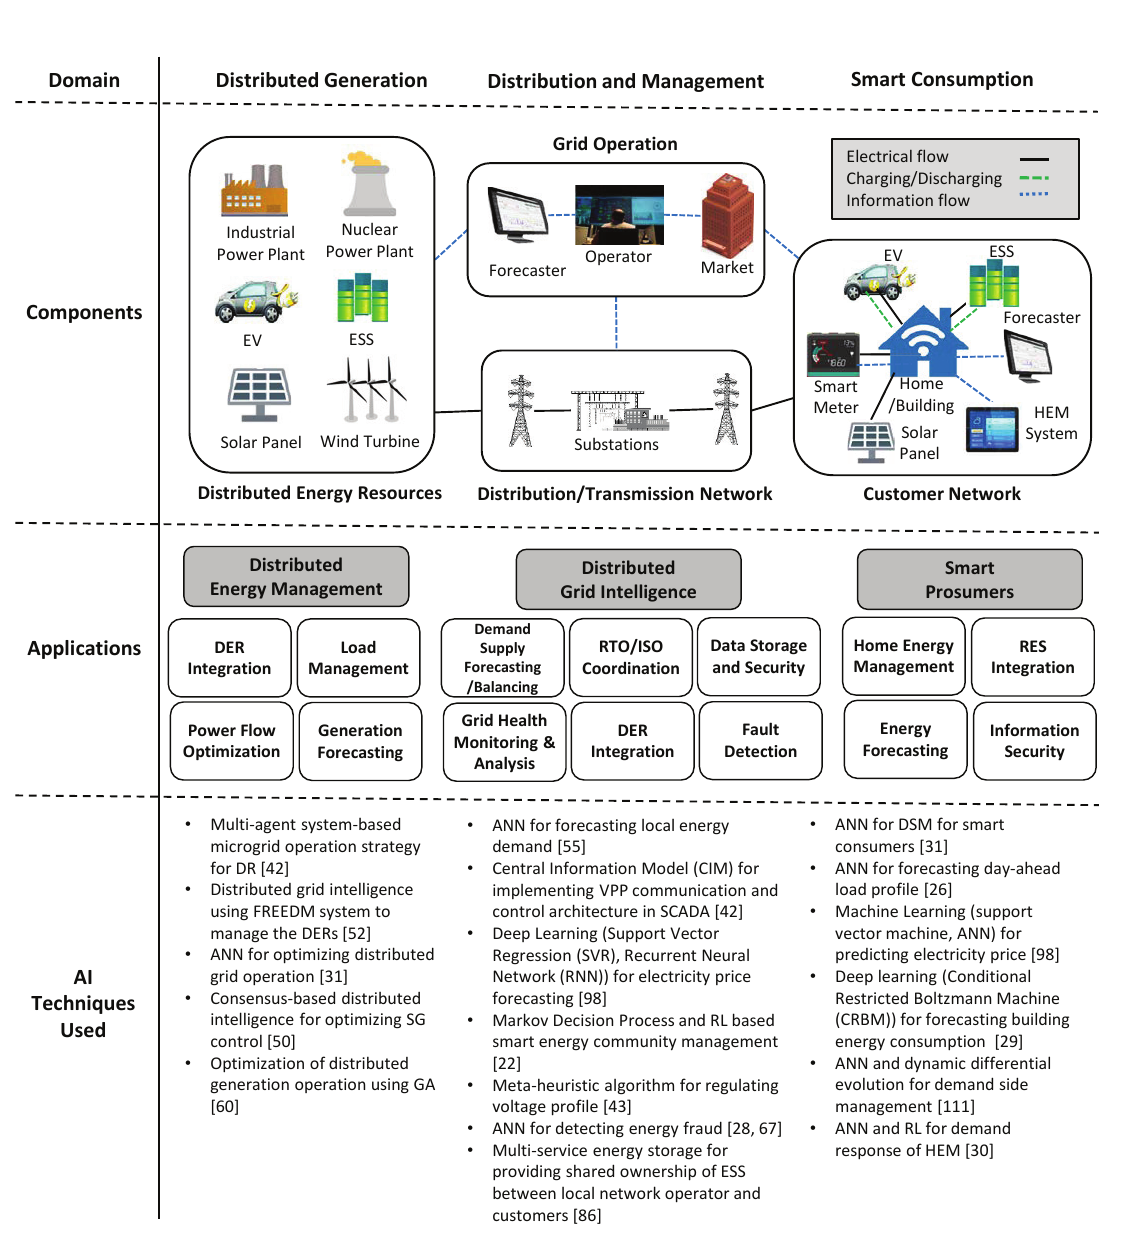
Figure 1. Overview of AI techniques in distributed smart